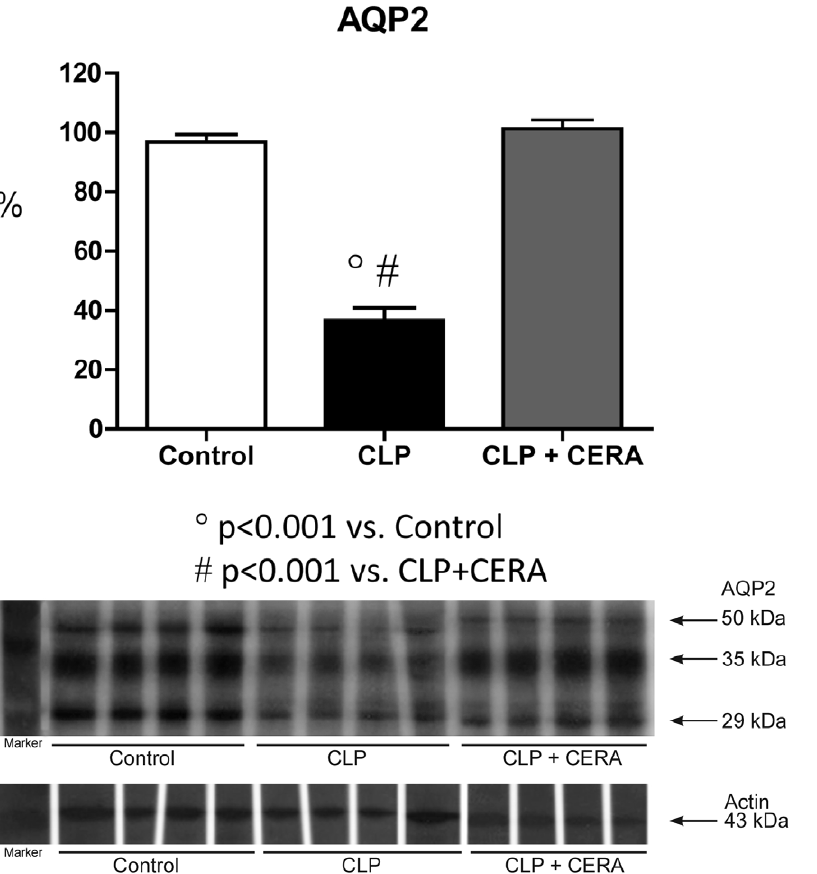
Figure 2. Aquaporin 2 expression was preserved in the rats pretreated with continuous erythropoietin receptor activator. Semiquantitative immunoblots prepared from kidney samples. Densitometric analysis of all samples from control rats, rats submitted to cecal ligation and puncture only, and rats treated with continuous erythropoietin receptor activator prior to undergoing cecal ligation and puncture. Differences among the means were analyzed by analysis of variance followed by the Student-Newman-Keuls test. P . 0.05 for control vs. CLP + CERA. CLP, cecal ligation and puncture; CERA, continuous erythropoietin receptor activator; AQP2, aquaporin 2.